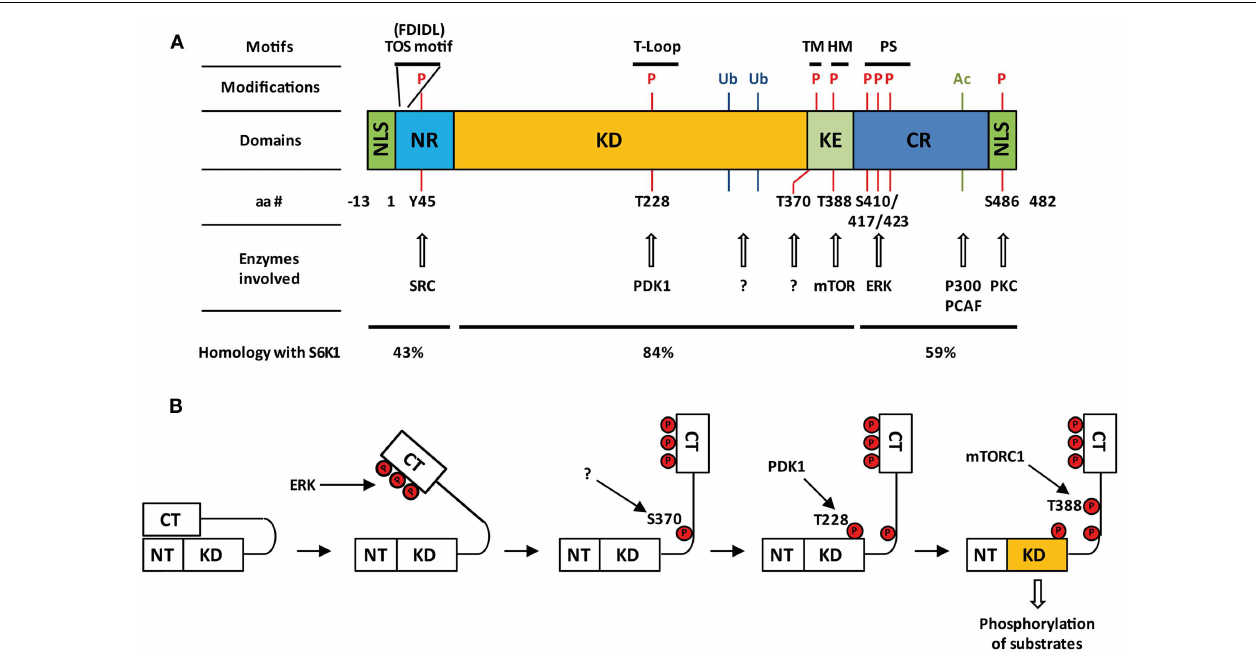
region (KE); C-terminal regulatory region (CR); pseudo-substrate domain (PS); turn motif (TM); hydrophobic motif (HM); pseudo-substrate region (PS); phosphorylation (P), ubiquitination (Ub); acetylation (Ac). (B) Step-wise model of activation of